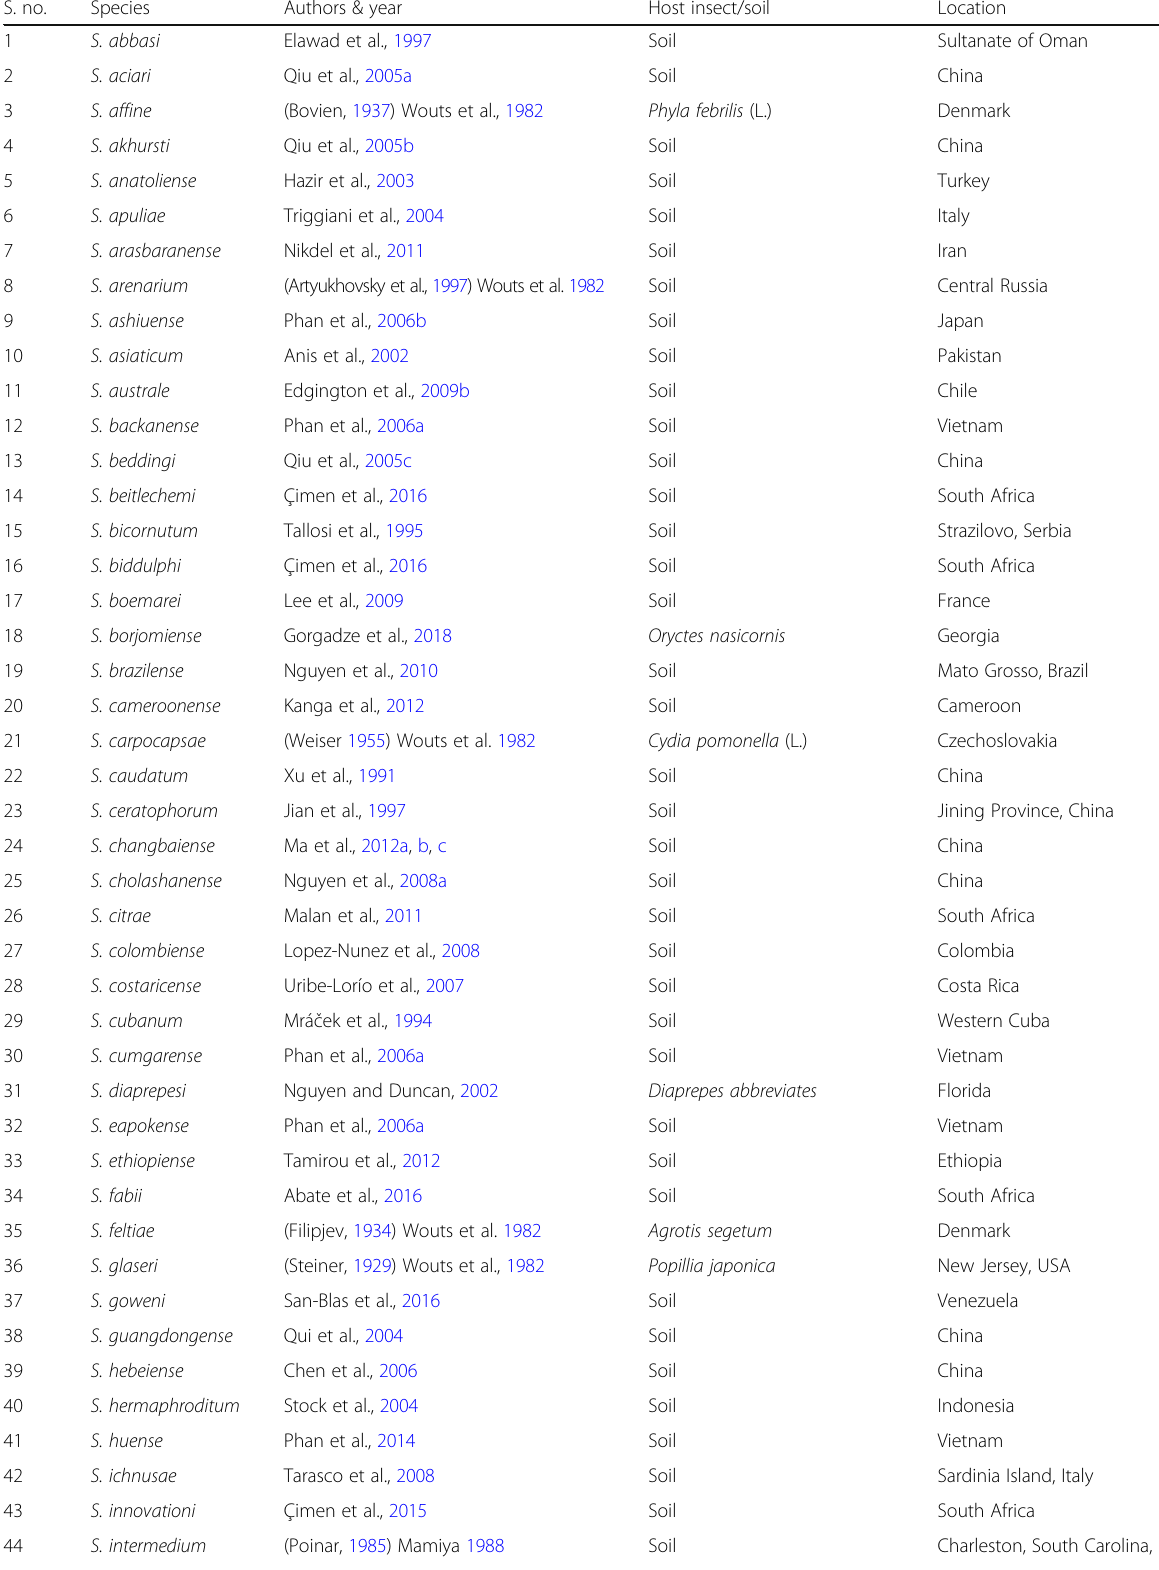
Table 1 List of Steinernema species recorded from different countries of the world S.